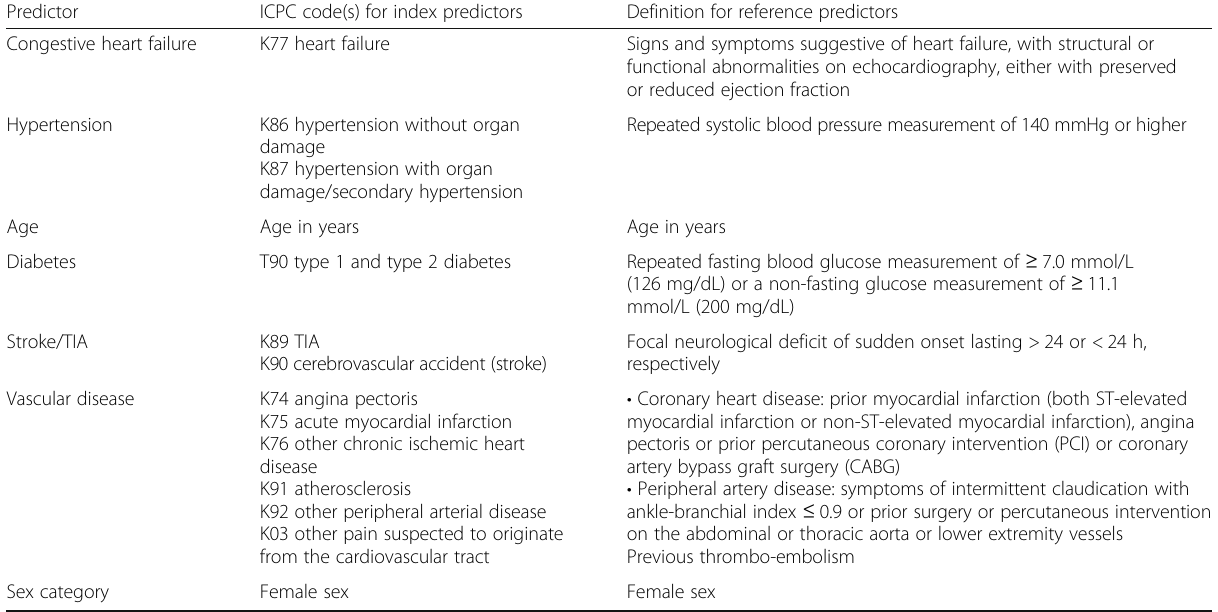
Table 3 Automatically extracted ICPC codes for the index predictors in the CHA2DS2-VASc model and the definition of the reference predictors used for manually scrutinizing the electronic patient file Predictor ICPC code(s) for index